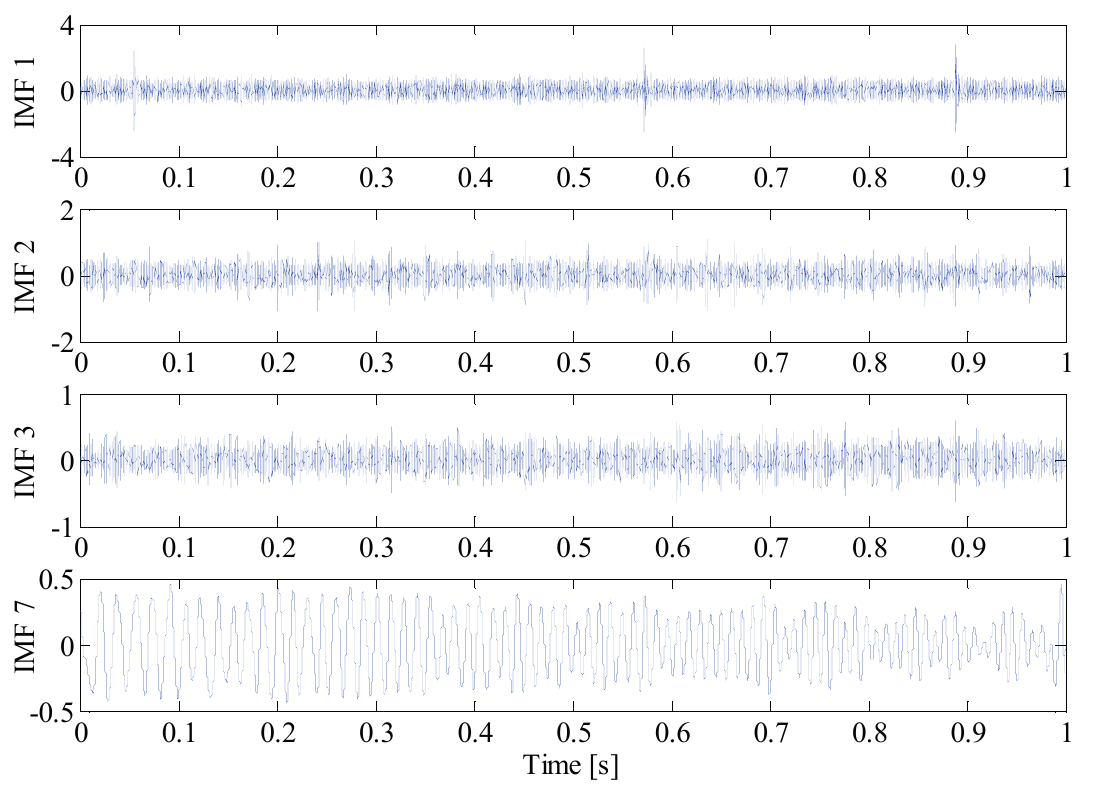
Figure 7. Several representative IMFs obtained by